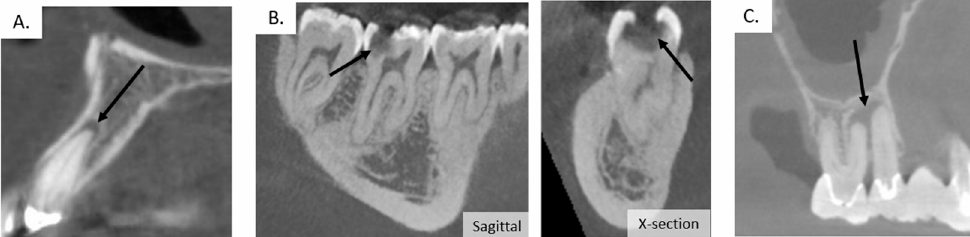
Figure 3. Cone beam computed tomography (CBCT) images detect the presence of apical inflam- matory lesions. This type of empirical evidence for oral infections is used as a method of deciding treatment course by dentists. ( A ) CBCT sagittal image shows an apical inflammatory lesion as a darker grey pocket surrounding the apex of tooth. ( B ) CBCT images show dental caries from sagittal and cross-sectional views. ( C ) Sagittal CBCT image shows large apical inflammatory lesion between the apices of adjacent teeth. From the author’s collection.